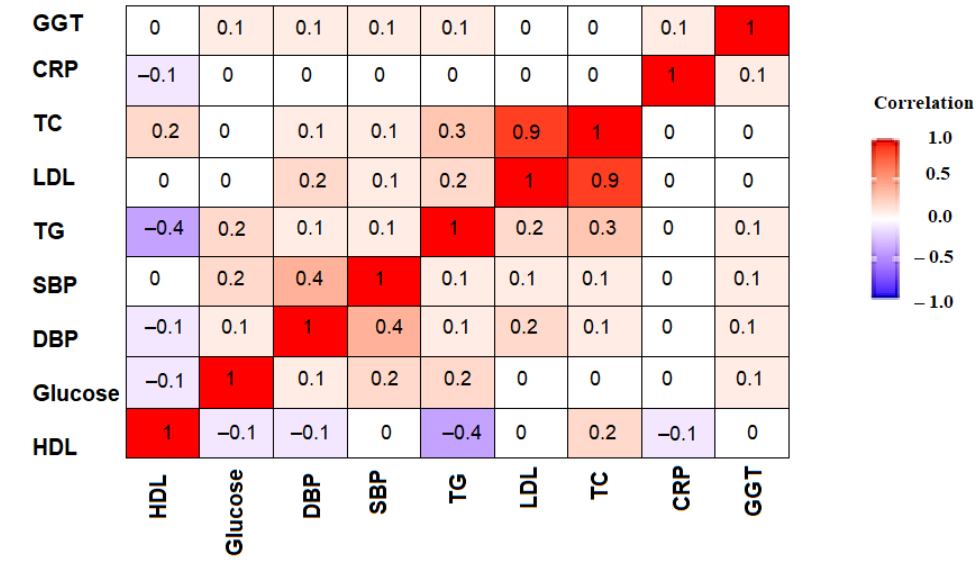
Figure 1. Cardiovascular biomarkers correlation matrix.